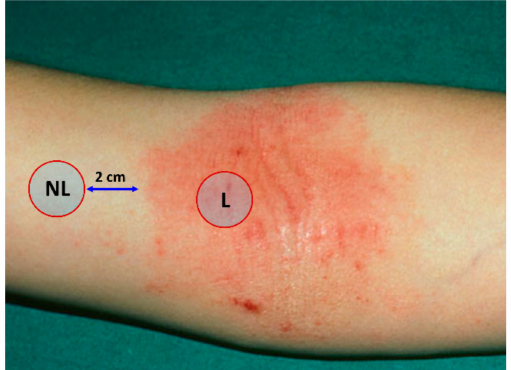
Figure 8. Lesional (L) and non-lesional (NL) skin sites for the stratum corneum collection.